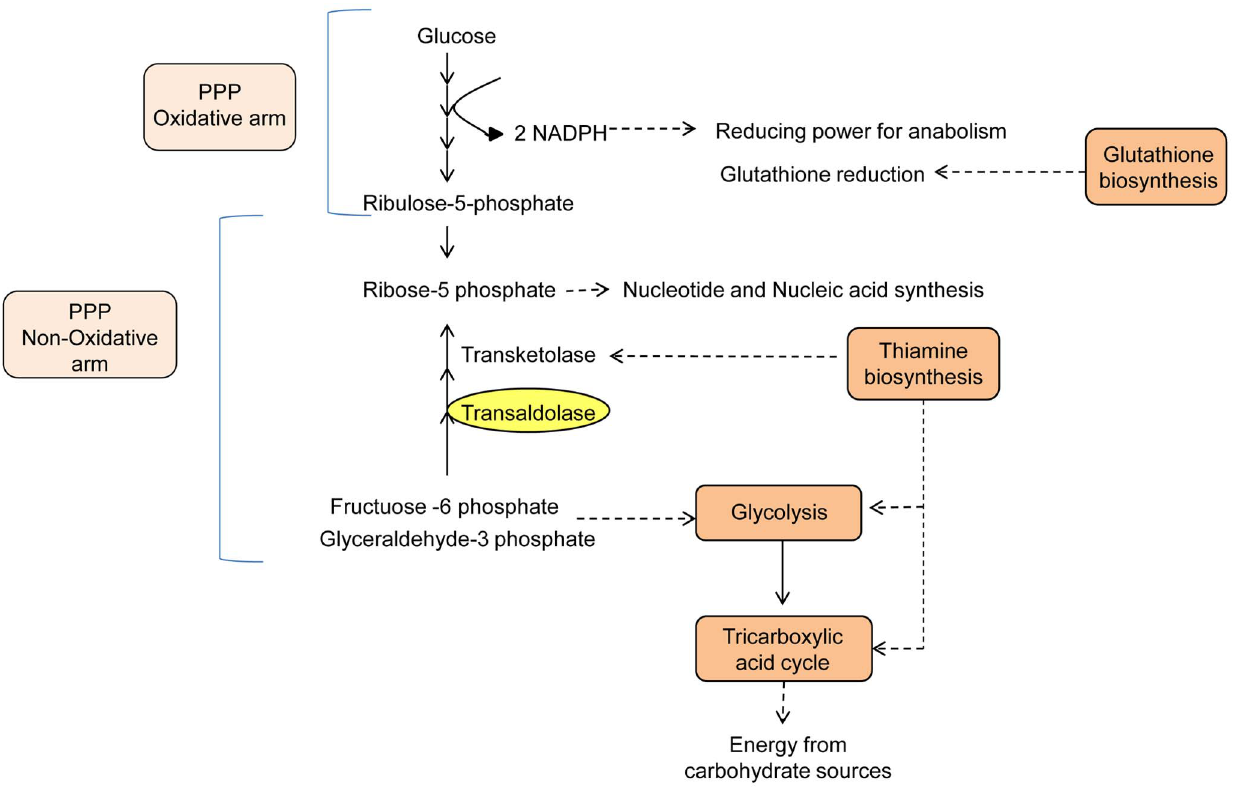
Figure 5. Metabolic processes in haustoria. Metabolic processes or specific enzymatic activities overrepresented in haustoria identified by B2G analysis and manual annotation are highlighted in this cartoon. Orange boxes and yellow ovals are metabolic processes or particular enzymes that showed statiscally significant upregulation in haustoria. Light orange boxes are metabolic processes where some genes showed statiscally significant upregulation in haustoria, and others showed a tendency to be more expressed in haustoria but were not statistically